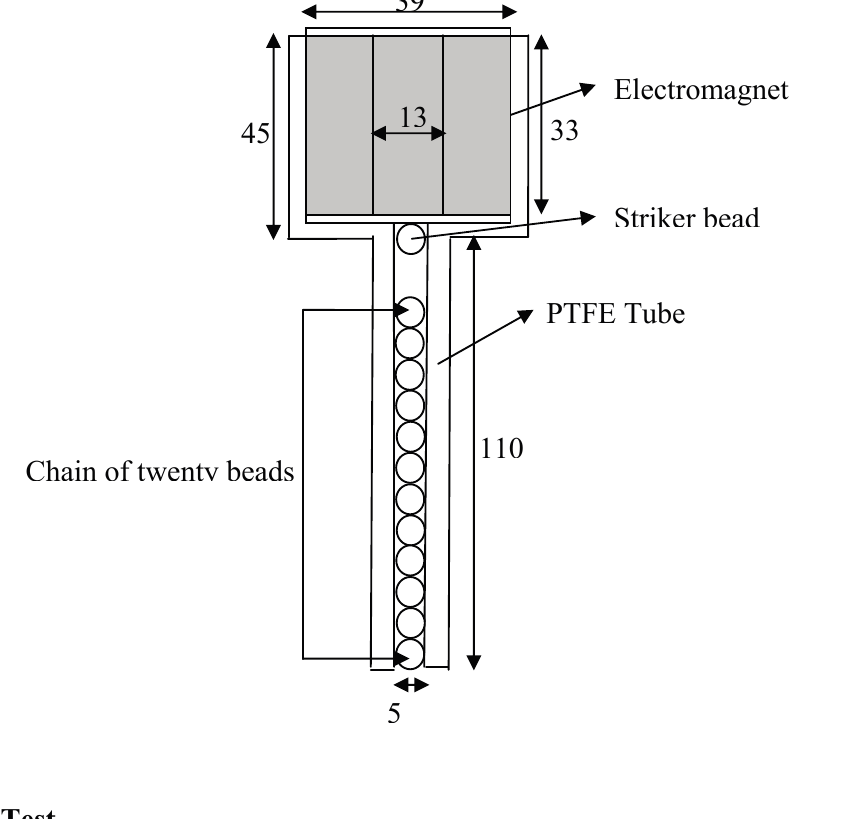
Figure 3. Schematic of the HNSW-transducer used in the study (dimensions are expressed in mm).